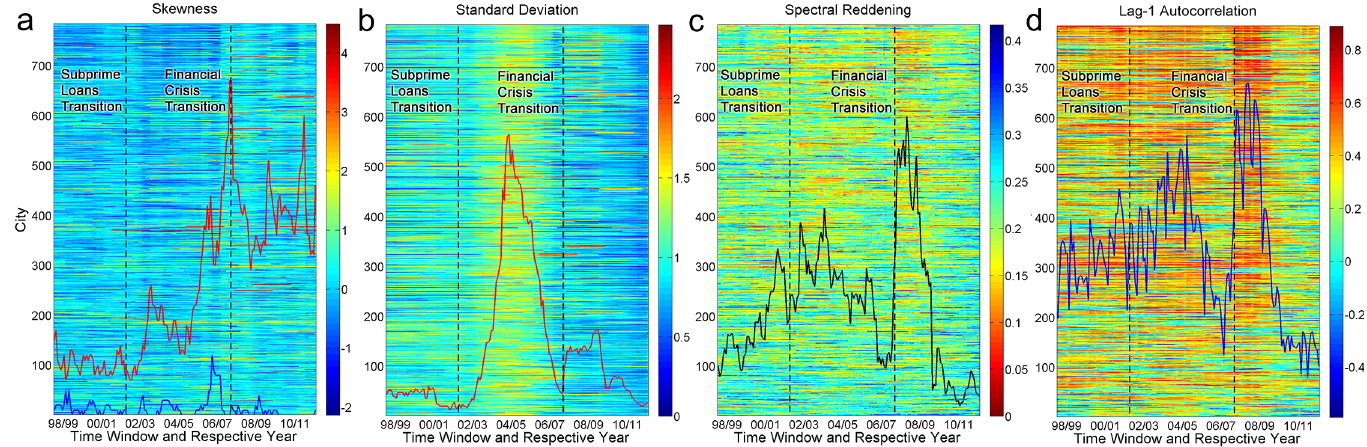
Fig 2. The vertical axis is the city index, ordered by the total number of transactions over the complete time series of the city. The horizontal axis is the time window and the color represents the strength of the corresponding early warning signal. Line plots indicate the number of cities that fall below a certain threshold for the corresponding early warning signal, scaled by an appropriate factor to fit onto the heat map. These line plots represent aggregated early warning signals that can be used to infer instability in the US housing market (Section S2 in S1 File). The first dashed line marks the time window with latest date corresponding to the Subprime Loans Transition whereas the second dashed line marks the time window with latest date corresponding to the Financial Crisis Transition. (a) Skewness. The blue line and red line corresponds to positive skewness, and negative skewness respectively. (b) Standard deviation. (c) Median frequency, ω 1/2 , a measure of spectral reddening. (d) Lag-1